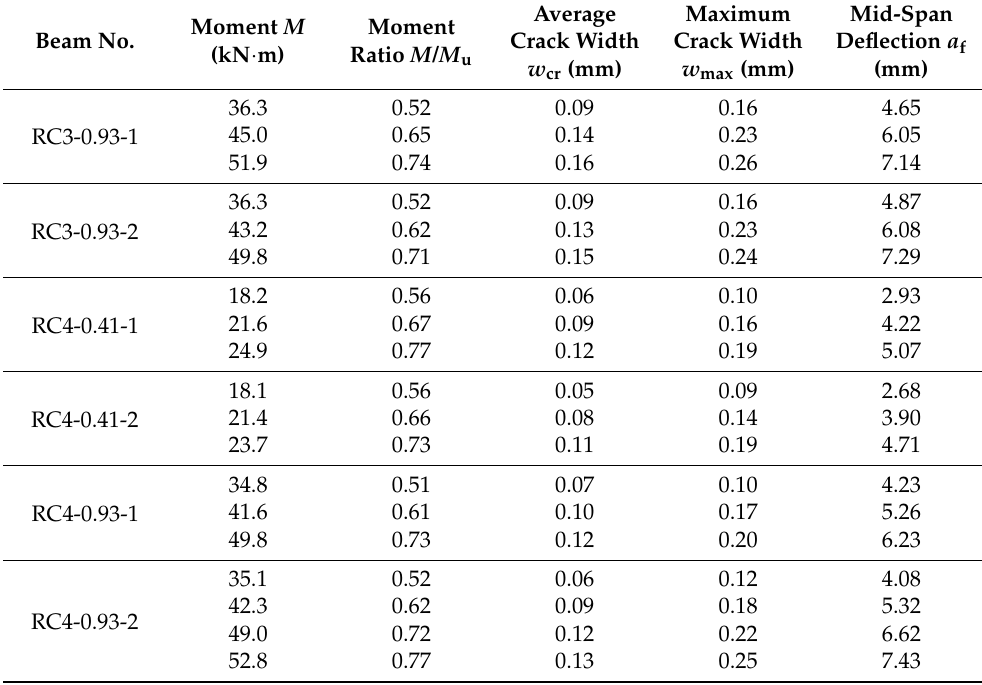
Table 5. Test data of crack widths and mid-span deflections of test beams. Beam Moment M Beam No.